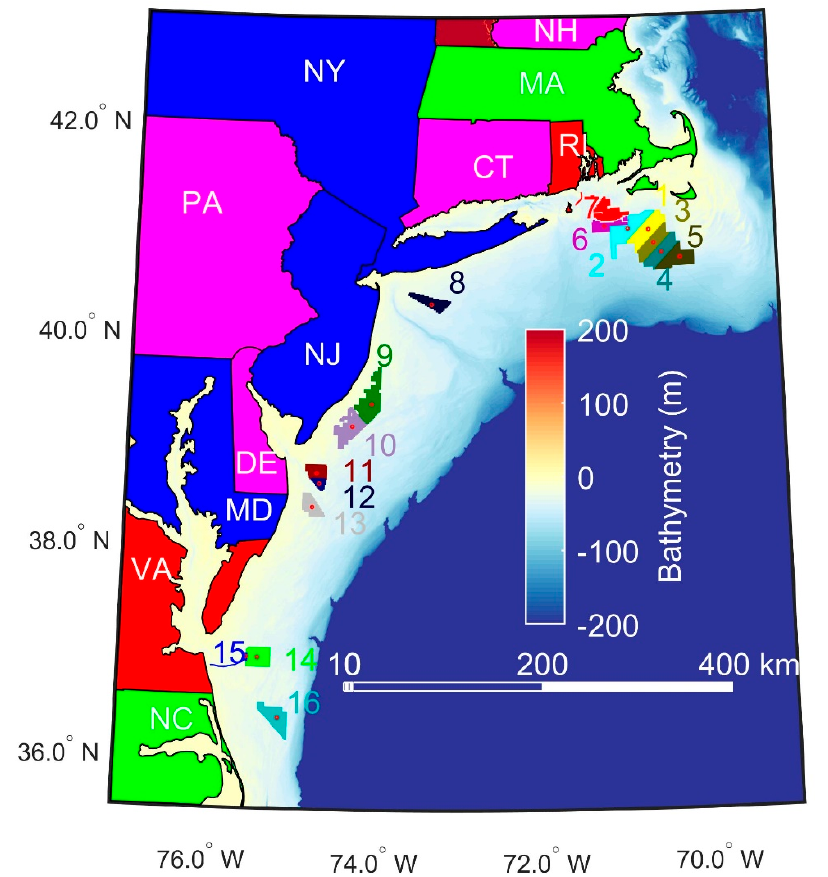
Figure 1. Map of the U.S. eastern seaboard showing bathymetry, states with potential for offshore wind (labelled using the two letter abbreviations given in Table 1 and colored according to the offshore wind energy potential expressed as installed capacity in GW) and locations of the 16 active LA (August 2020). States filled in magenta (CT, DE, NH, PA) have <10 GW offshore wind energy potential, states filled in red (RI, VA) have gross potential of 10–100 GW, states filled in blue (MD, ME, NJ, NY) 100–300 GW and states filled in green (MA, NC) > 300 GW [5]. ME which is north of NH is not shown on the map.